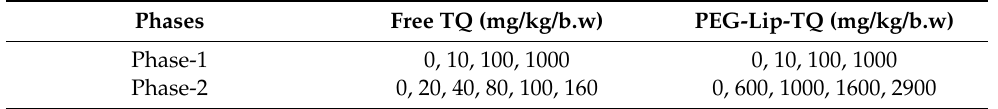
Table 1. Free TQ and PEG-Lip-TQ doses in both phases of the in vivo oral acute toxicity assay in Swiss albino mice. Phases Free TQ (mg/kg/b.w) PEG-Lip-TQ (mg/kg/b.w) Phase-1 0, 10, 100, 1000 0, 10, 100, 1000 Phase-2 0, 20, 40, 80, 100, 160 0, 600, 1000, 1600,